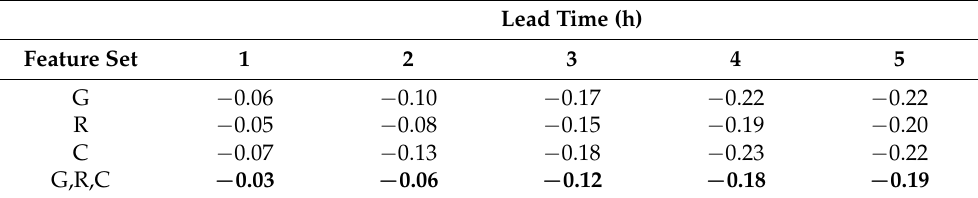
Table 4. Bias values of the ML models that use only one QPE and of the models that use all three QPEs for different lead times. Best values (closest to zero) for a lead time are highlighted in bold. Lead Time (h) Feature Set